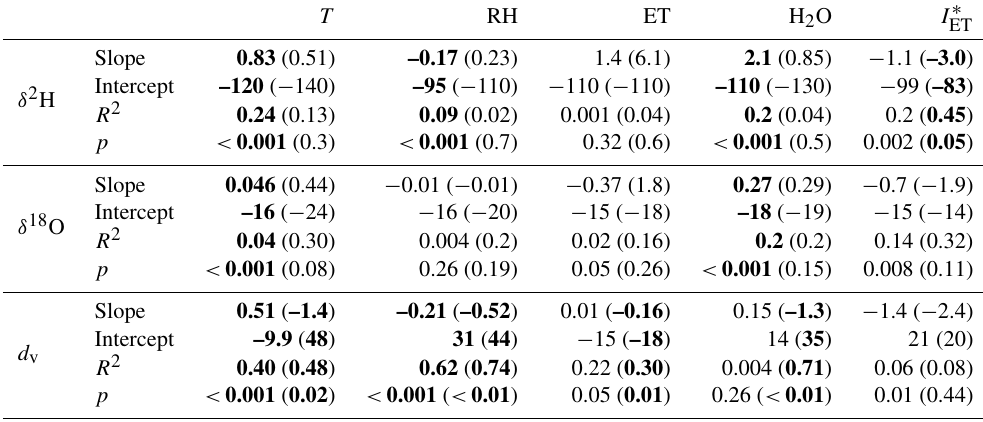
Table 1. Correlation between meteorological variables and the isotopic composition of water vapour. Values outside the brackets are statistics for the hourly observations. Inside the brackets are correlation statistics for average values calculated between 11:00 and 15:00LST, hence representing activity during a convective boundary layer. Significant correlation are shown in bold; p < 0.001 for hourly observations and p < 0.05 for the daytime averages (due to the smaller number of points).